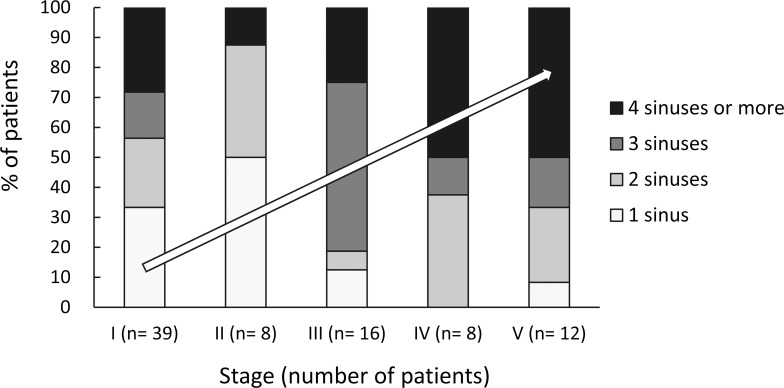
Percentages of sinuses involved in 83 patients by stage of orbital complications of sinusitis.There was a trend of a positive association between stage and the number of sinuses involved. The most frequently involved numbers of sinuses were 1 for stages I and II, 3 for stage III, and 4 or more for stages IV and V.